Question: In a single sentence, describe what this figure presents.
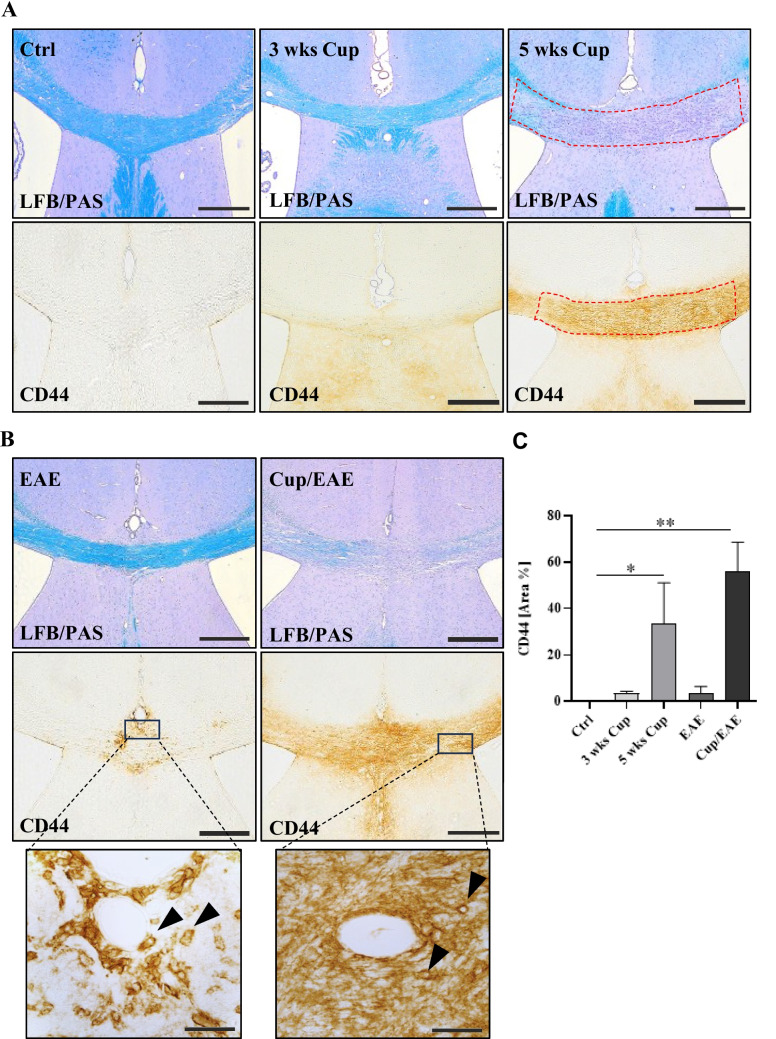
Answer: CD44 expression in different MS animal models. A Representative LFB/PAS and anti-CD44 staining showing an apparent relationship between demyelination severity in the medial corpus callosum (CC) and CD44 expression in control (Ctrl), cuprizone 3 weeks (Cup 3 wks), Cup 5 wks; The demyelinated areas are marked by dashed red lines; Scale bar: 250 µm. B Representative LFB/PAS and anti-CD44 staining in EAE, and Cup/EAE groups. Distinct CD44 positive cells are marked by closed arrowheads. Scale bar: 250 µm; insets: 10 µm. C Quantification of CD44 density in the medial CC. Statistical analysis was performed using Kruskal–Wallis test with Dunn’s post hoc test. Data are shown as mean ± SEM. Significant differences are indicated by asterisks (*p ≤ 0.05 and **p ≤ 0.01)